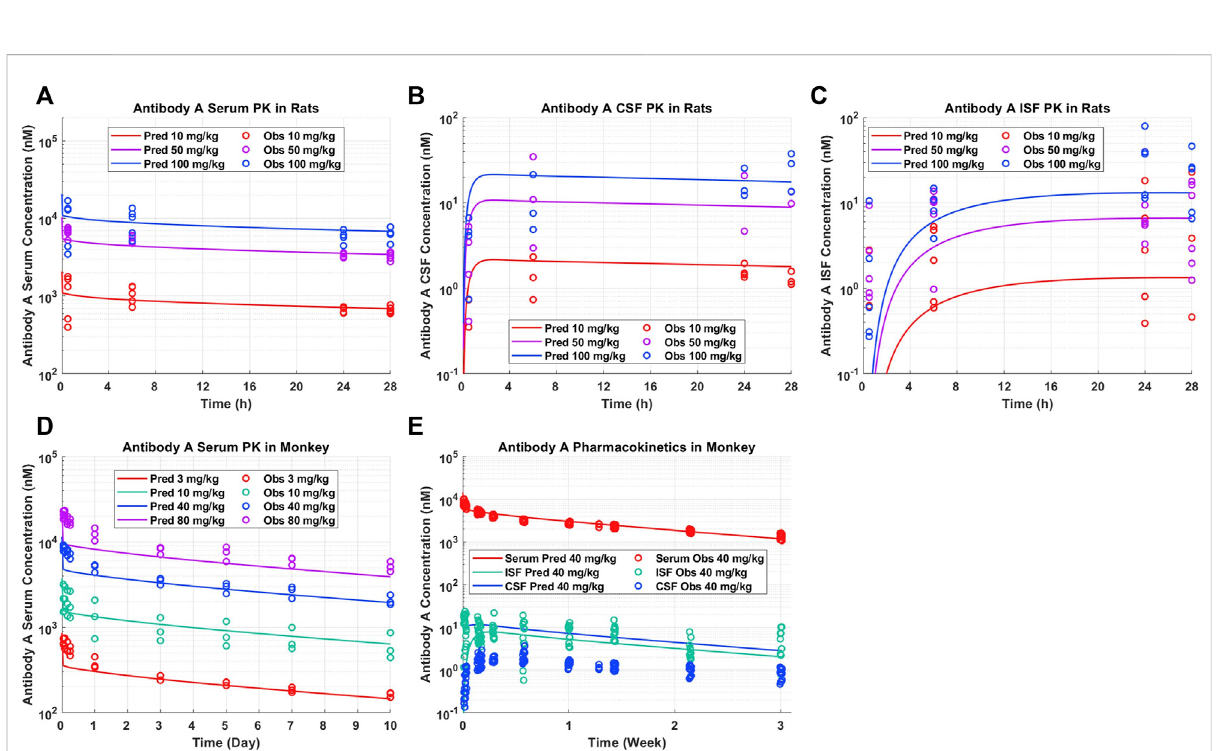
in rhesus monkeys administered 40 mg/kg IV. A priori model predictions are displayed as solid lines and observed data as